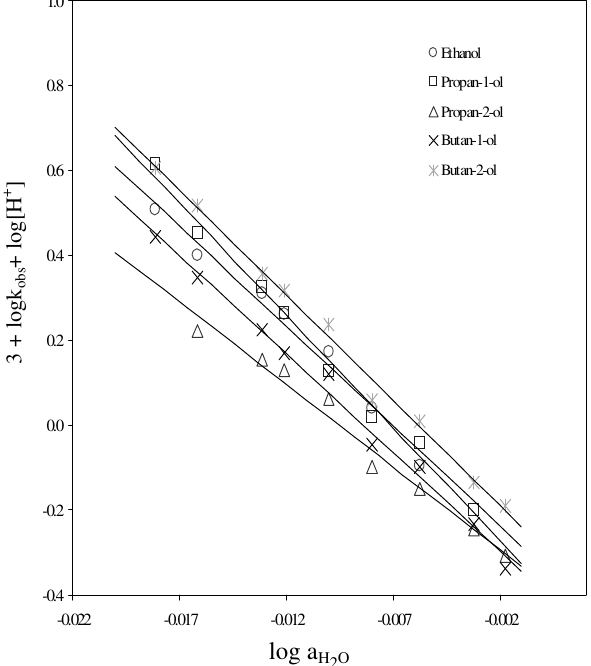
Figure 6. Bunnett plots in perchloric acid